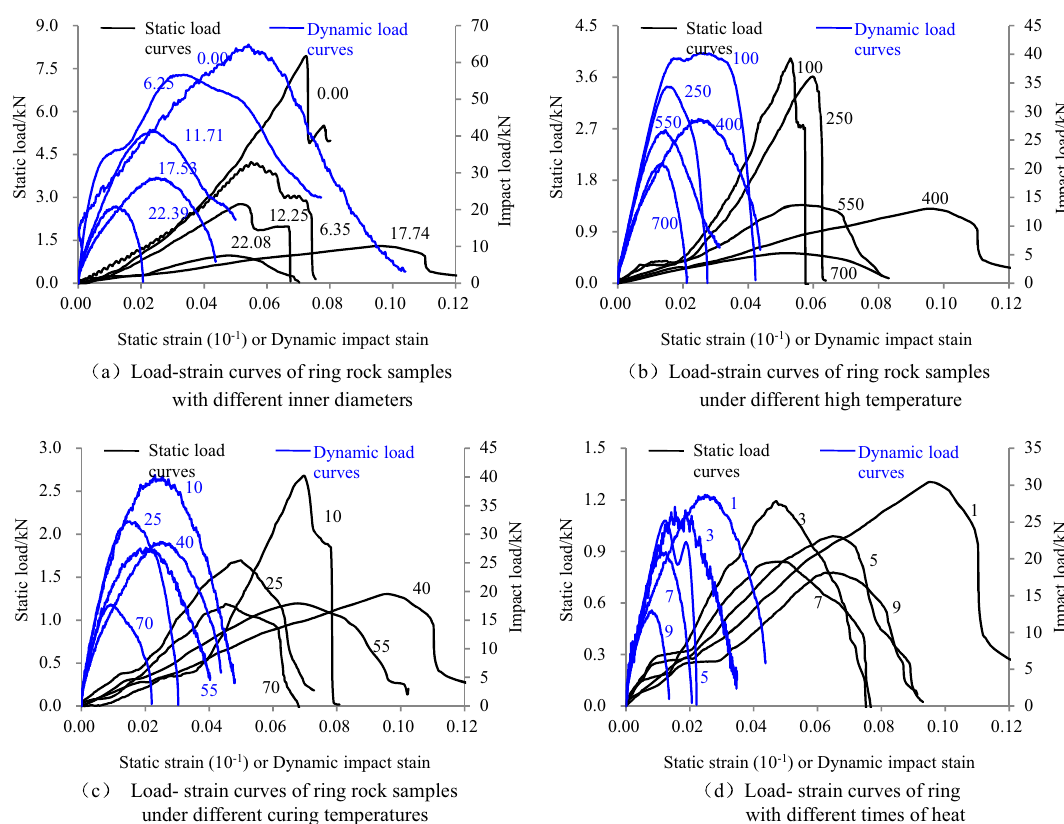
Figure 1. Load-strain curves of circular granite under the condition of water-heat cycles (The figures in ( a ) represent the inner diameter of the circular granite samples, and their units are mm. The figures in ( b ) represent the high temperature at which the circular granite samples were processed, and their units are °C. The figures in ( c ) represent the water temperature for curing the circular granite samples, and their units are °C. The figures in ( d ) represent the cycle heat recovery times of circular granite samples, and their units are time. The inner diameter of the rock samples are all about 18 mm in ( b – d specimens were immersed in water at the same temperature for 1 h; one cycle heat recovery means including one high temperature treatment and one water temperature curing.